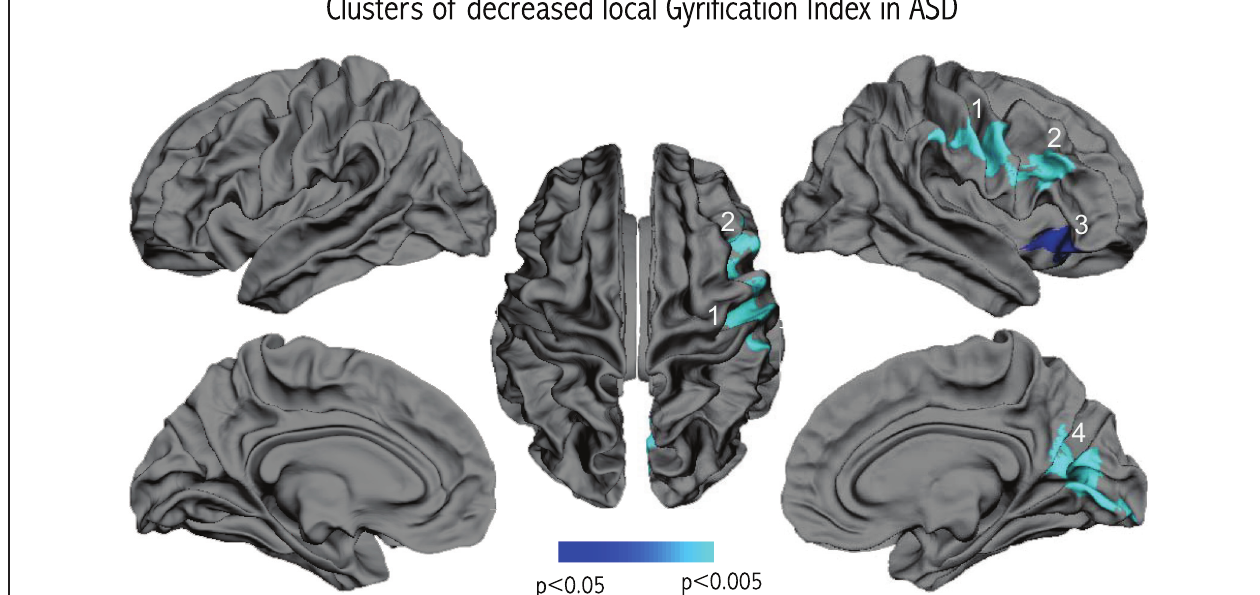
FIGURE 2 | Results of the vertex-wise comparison of l GI between groups . Four clusters of reduced l GI were observed in the group of children and adolescents with ASD compared to controls after correcting for multiple comparisons.